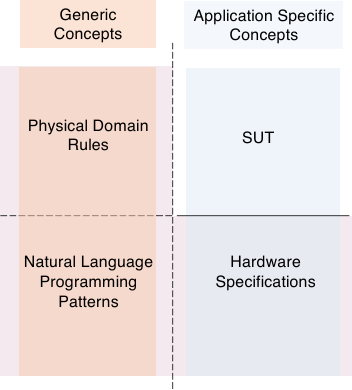
Figure 4. The three components of the knowledge base and the conceptual dependencies among them and the software under test (SUT).